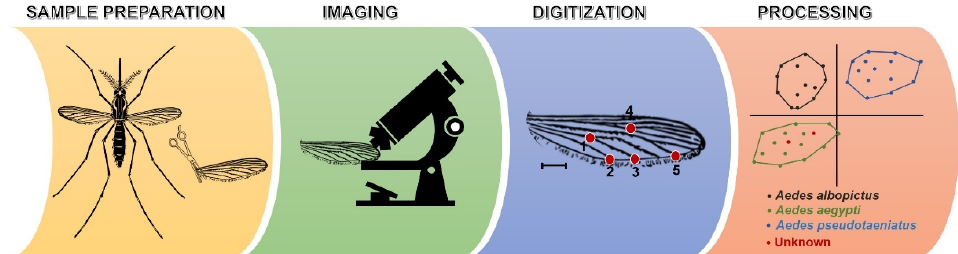
Figure 3. Steps of medical parasite and arthropod diagnoses using geometric morphometric analy- sis. An unknown sample is prepared on a glass slide or any solid support. A defined structure of an unknown sample is photographed and submitted to XYOM software (https://xyom.io, accessed on 14 August 2021) [63] or related tools. The image file input is scaled, landmark digitized, and statis- tically analyzed.